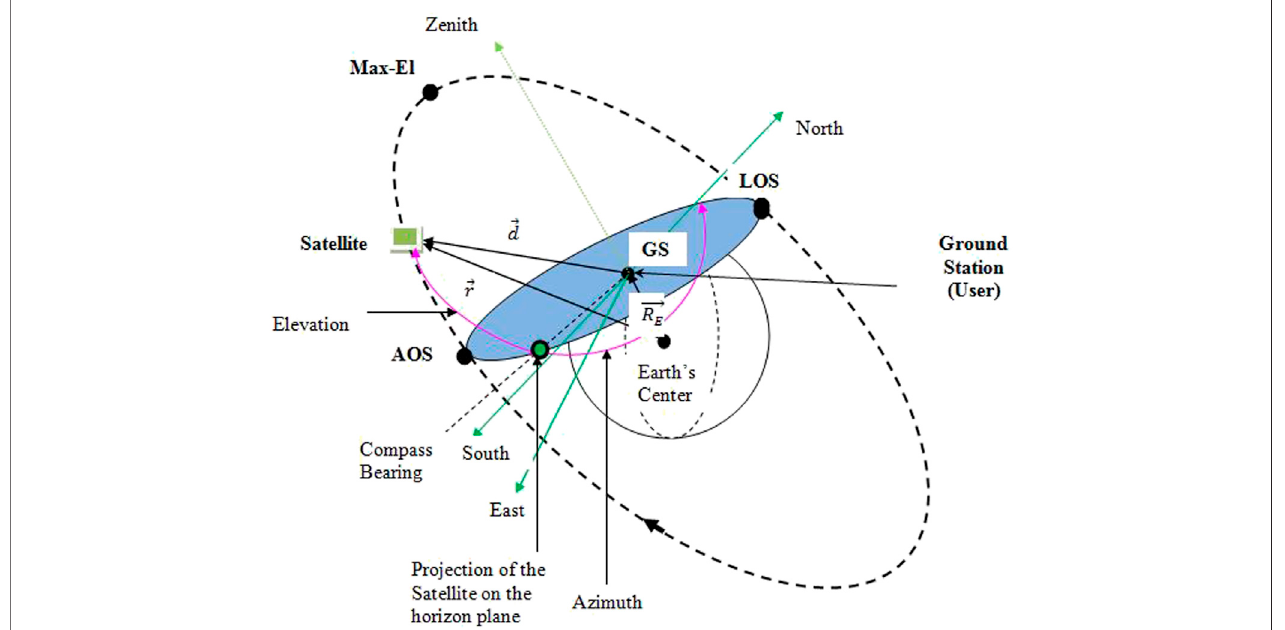
FIGURE 3 | Horizon plan and slant